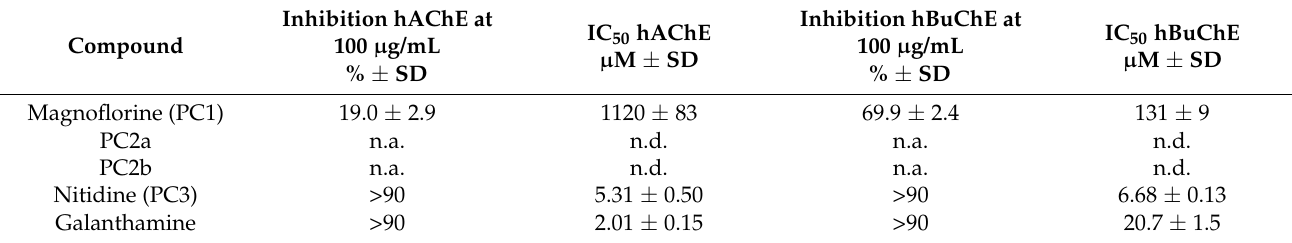
Table 4. Anticholinesterase activity of isolated phytocomponents and reference compound galanthamine, a drug in the market for the treatment of Alzheimer Disease. Inhibition hAChE Compound